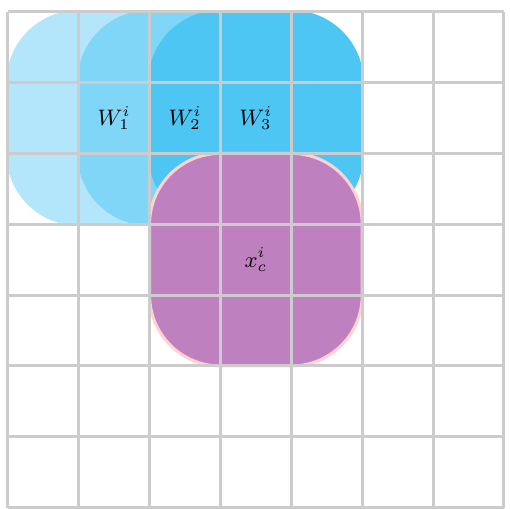
Figure 1. The large sliding window and small patches inside the